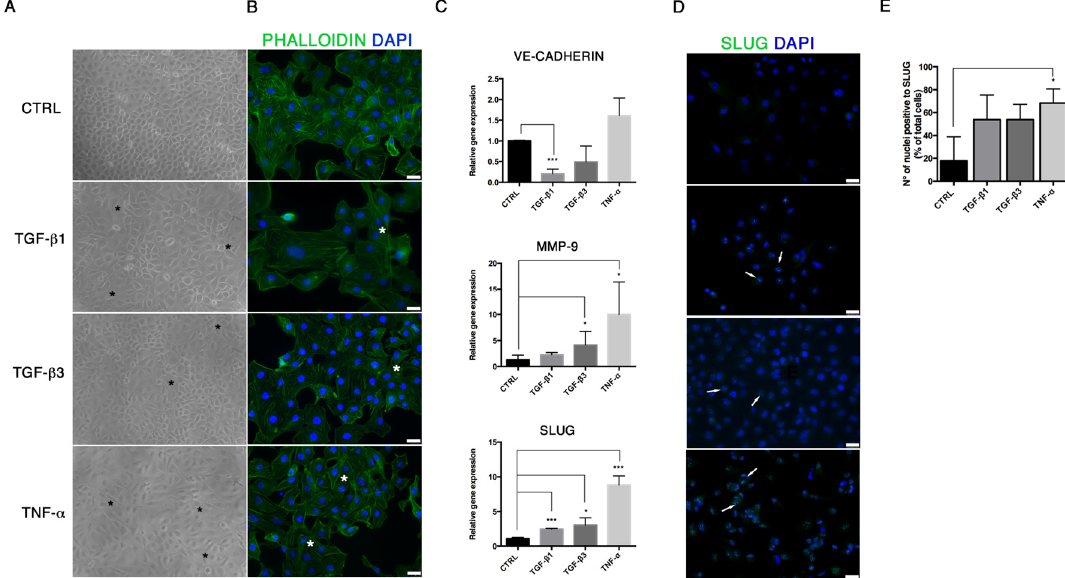
Figure 1. TGF- β 1, TGF- β 3 and TNF- α stimulate the expression of End–MT markers. ( A ) Morphological variations occurring in HUVECs after 24 h exposure to TGF- β 1, TGF- β 3 and TNF- α , observed under the light microscope at 20 × magnification. Black stars indicate the cells that acquired a mesenchymal shape. ( B ) Cytoskeletal changes seen with F-actin immunofluorescence (20 × magnification). White stars indicate cells with elongated shape. ( C ) Gene expression analysis of VE-cadherin, MMP-9 and SLUG, performed by Real-Time PCR in HUVECs after 24 h exposure to TGF- β 1, TGF- β 3 and TNF- α . Results are reported as fold changes relative to untreated controls. ( D ) Immunofluorescence analysis of SLUG (green spots inside nuclei, indicated by white arrows) (20 × magnification). ( E ) Quantification of SLUG-positive cells expressed as percentage of cells with nuclear positivity/total cells. Scale bars = 25 µ m. All data are expressed as mean ± SD of at least 3 independent experiments, and statistical analysis was performed by unpaired Student’s t -test; *, p < 0.05; ***, p < 0.001. MMP-9, matrix metalloproteinase 9; SLUG (SNAI2), snail family transcriptional repressor 2; TGF, transforming growth factor; TNF, tumor necrosis factor; VE-CADHERIN, vascular endothelial cadherin.